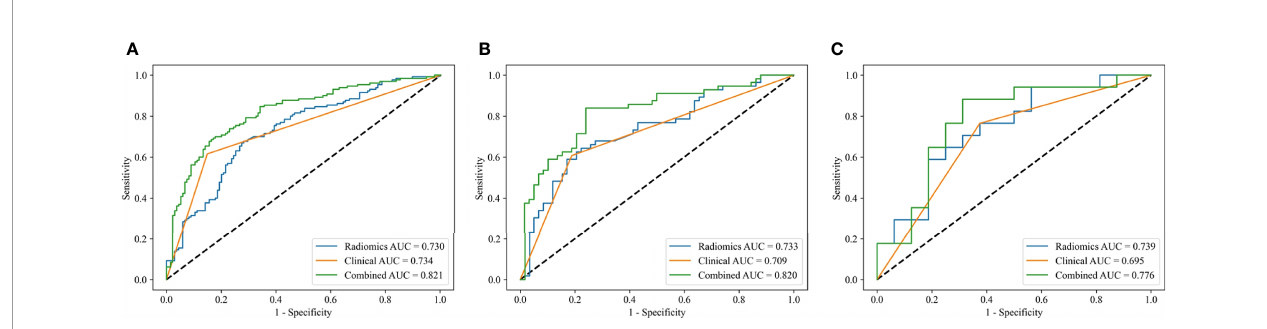
FIGURE 5 | ROC curves of the radiomics models, clinical models and combined models constructed by L-SVM in the training (A) , internal test (B) and external test